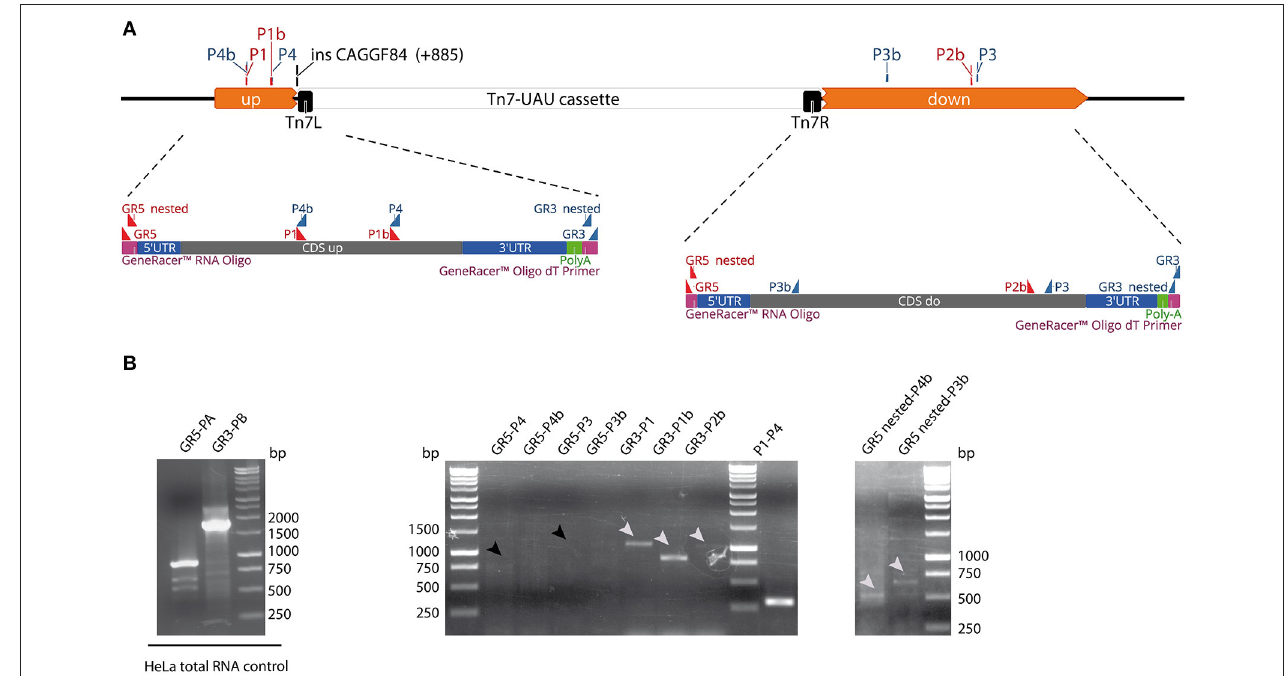
FIGURE 4 | RACE analysis. (A) Map of Tn7 mutated orf19.2646 . Orf19.2646 (gray) is interrupted by the Tn7-UAU cassette (white bar). The putative transcripts drawn between the dotted lines have been ligated to a 5 ′ GeneRacer TM Oligo and 3 ′ GeneRacer TM Oligo dT primers (purple). The forward primers (P1, P1b, and P2b, red triangles) are designed to amplify a products with the GeneRacer 3 ′ primer (GR 3 ′ ), while the reverse primers (P3, P3b, P4, and P4b, blue triangles) are designed to amplify products with the GeneRacer 5 ′ primer (GR 5 ′ ). (B) Left panel: Control PCR with HeLa total RNA. Middle panel: RACE PCRs performed with the GR5 ′ , the GR3 ′ primers and with the P1-P4 primers on SC5314 RNA as control of reverse transcription. Right panel: Nested PCR performed on the GR5-P4 and GR5-P3 PCR products (black arrows). Topo cloning was performed on the products indicated by a white